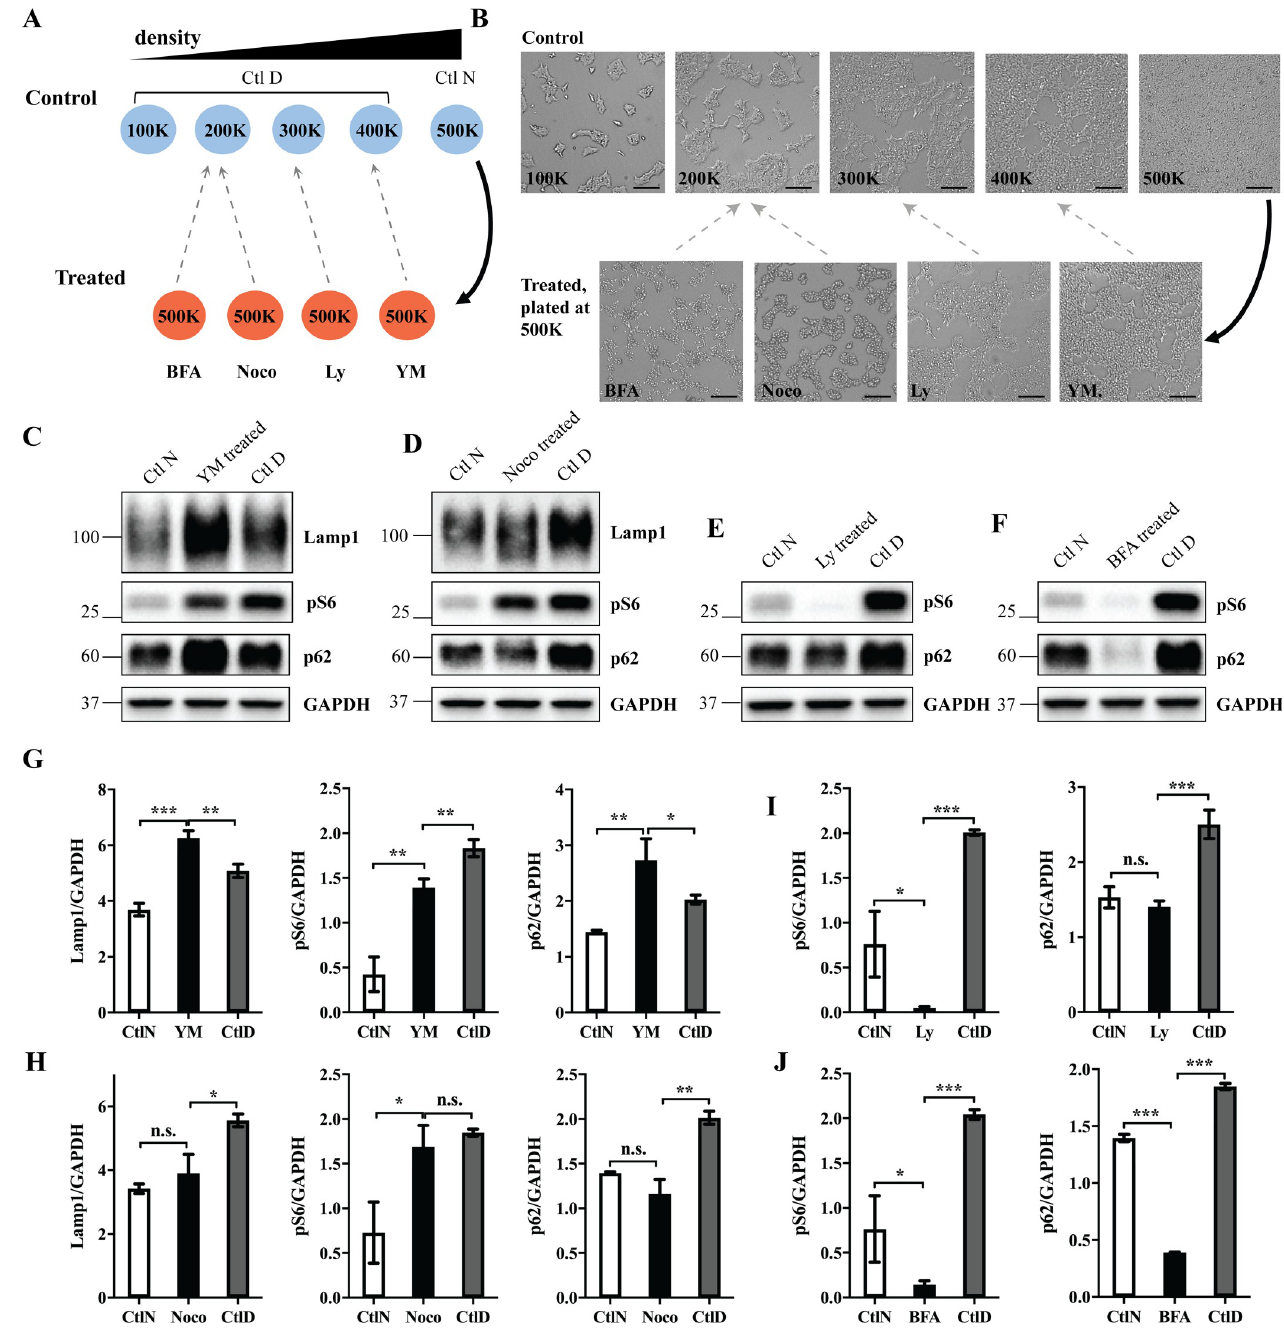
Fig 6. Cell density affects experimental outcomes. (A) HEK 293FT cells were plated in 6 well-plates according to the following scheme: 5 sets of control cells at a range of densities (100-500K cells per well) and 4 sets of cells at the highest density (500K cells per well) for treatment. All control cells were treated with the vehicle (control), and the remaining 4 sets were treated with 25 μ M Ly294002 (Ly), 2.5 μ g/ μ l Brefeldin A (BFA), 100 ng/ml nocodazole (noco) or 800 nM YM- 201636 (YM), for the last 20h before lysis. Ctl N, control cells plated at the same number (500K) as the treated cells; Ctl D, control cells with matching cell density at the experimental endpoint. In classical experimental design, Ctl N is used as a control. (B) Cells were imaged before the lysis and matched with one of the controls based on cell density. Scale bar, 100 μ m. (C-F) Cell lysates were analyzed by Western blotting using indicated antibodies. Ctl N and Ctl D were simultaneously compared with treated cells. GAPDH was used as a loading control. (G-J) Western blot images were quantified and the values normalized to GAPDH; Bar graph data are mean ± SD. � p < 0.05, �� p < 0.01, ��� p < 0.001.